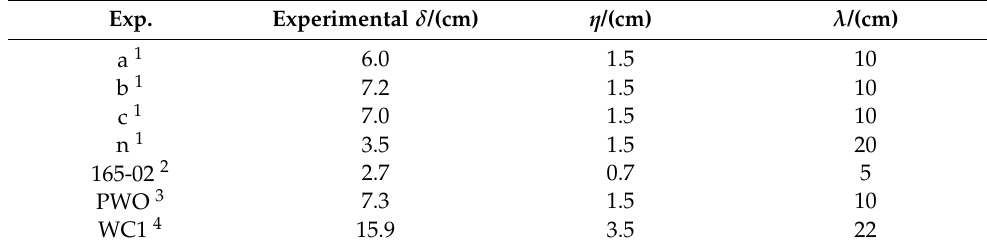
Table 1. Experiments conditions and estimates of δ . Exp.